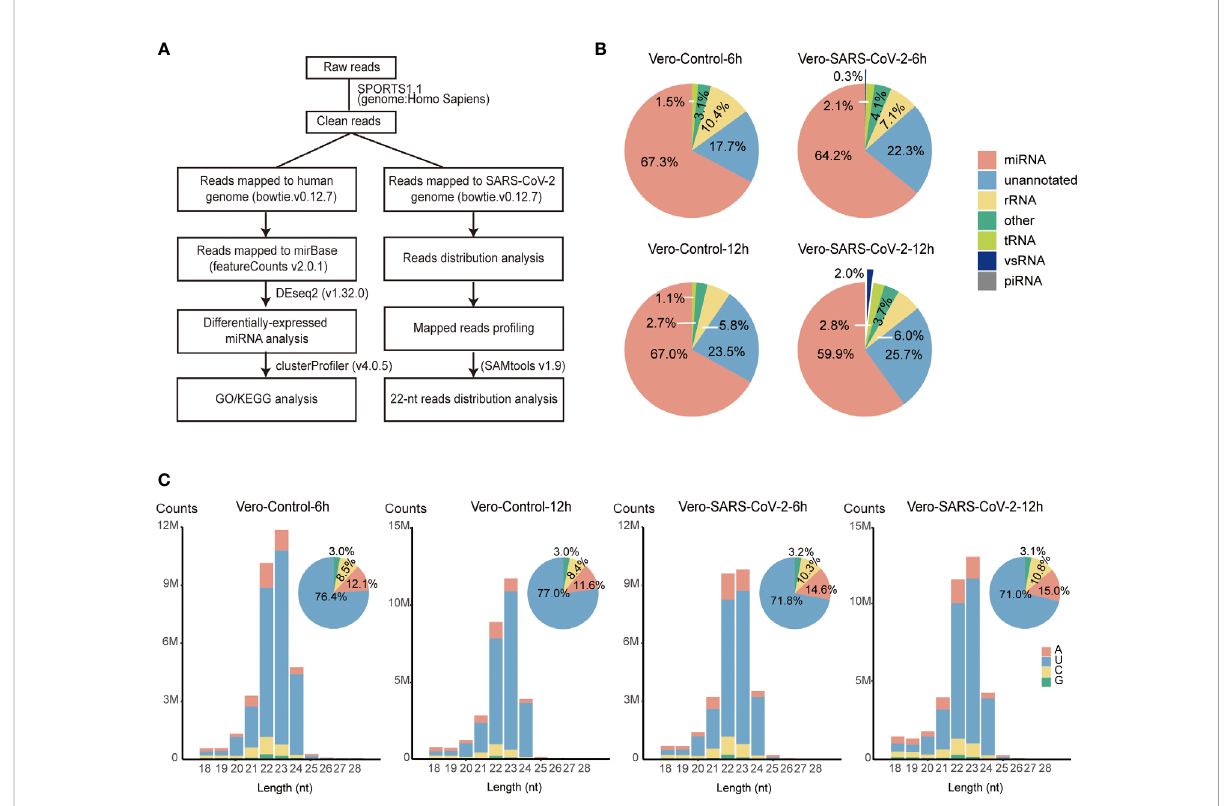
FIGURE 1 Overview of small RNAs in SARS-CoV-2-infected Vero cells. (A) The schematic work fl ow for small RNA analysis. (B) Fractions of small RNAs in control and virus-infected (6 hpi/12 hpi) Vero cells. (C) Size distribution of total sRNAs in control and virus-infected (6 hpi/12 hpi) Vero cells. Clean reads are aligned to the human reference. Mapped reads without matching to tRNA and rRNA are classi fi ed by length and are shown as read counts. Pie plots represent sRNAs initiated with A/U/C/G in control and virus-infected Vero